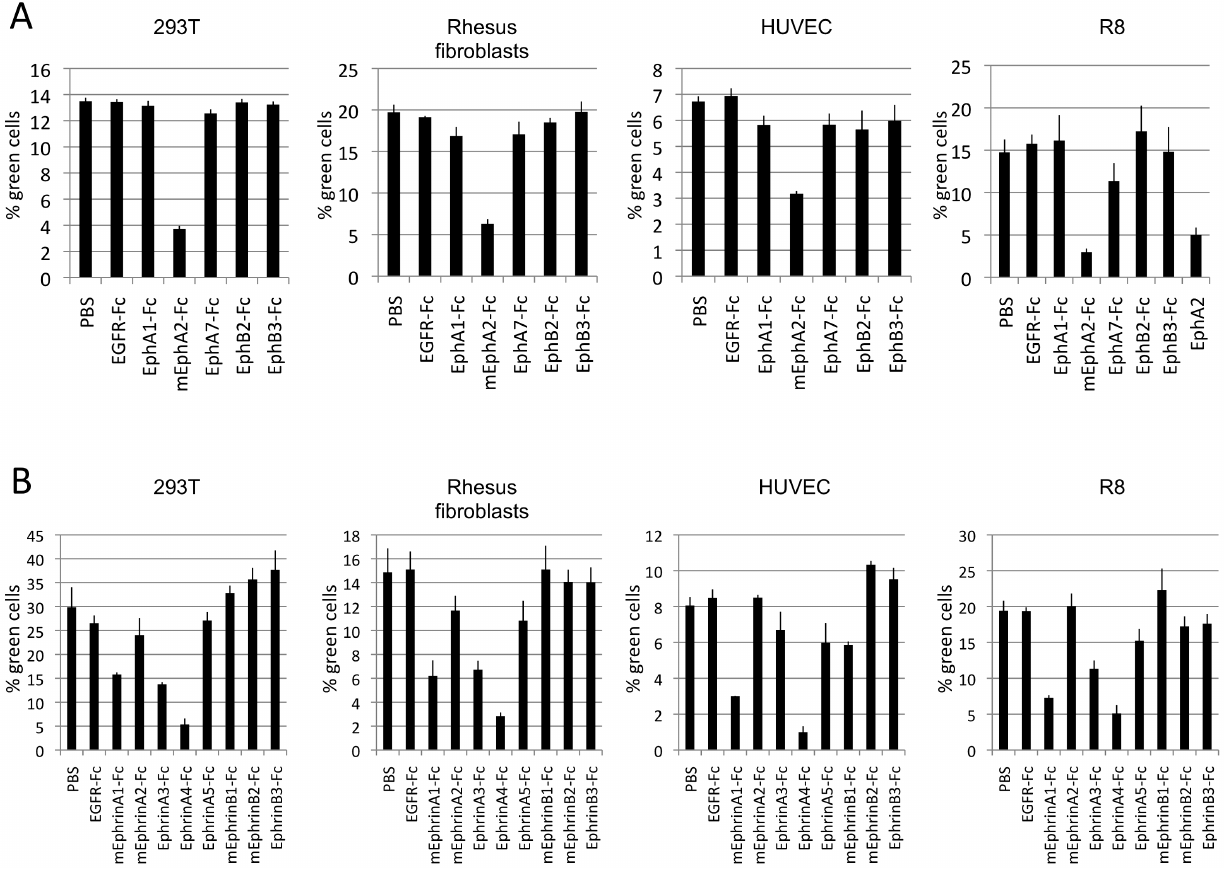
Figure 5. Inhibition of KSHV entry by soluble Eph proteins and soluble Ephrins. ( A ) rKSHV.219 was pre-incubated with the indicated soluble Eph-Fc fusion proteins at 1 m g/ml for 45 min. Entry was quantified by flow cytometry. (n=3; error bars indicate sd) ( B ) Inhibition of KSHV entry by soluble Ephrins. Target cells were pre-incubated with the indicated Ephrin-Fc fusion proteins at 5 m g/ml for 30 min followed by infection with rKSHV.219. Entry was quantified as in (A). PBS and EGFR-Fc serve as controls. (n=4 for HUVEC and R8, else n=3; error bars indicate sd).